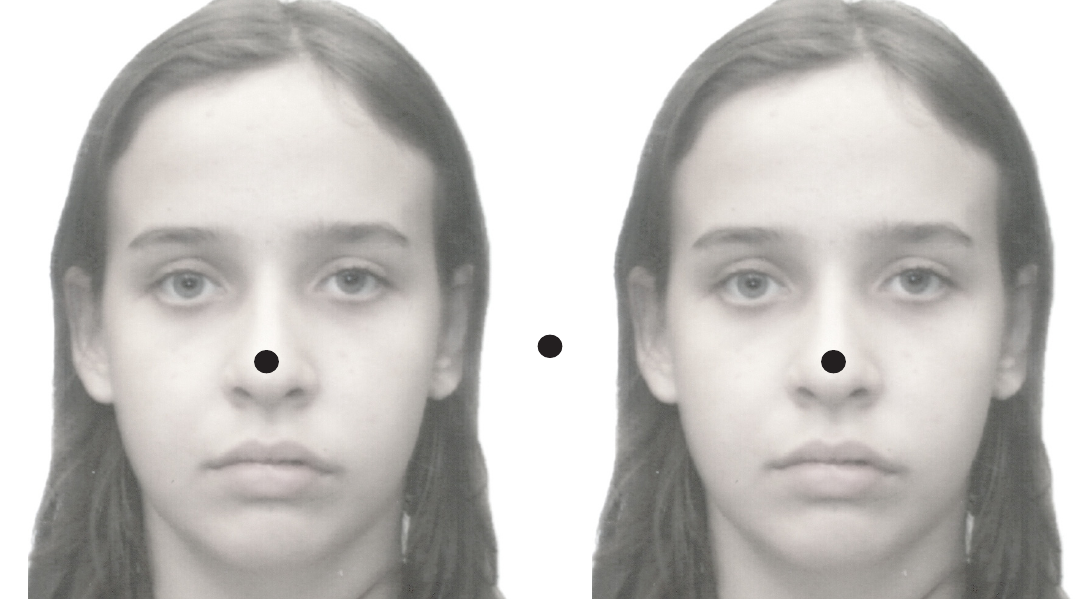
Figura 2. Faces-estímulo para observação do fenômeno de muitas-faces no lado contralateral ao ponto cego. O ponto de fixação é sempre o do centro. Por exemplo, com o olho direito fechado fixe o ponto central e mova o papel para frente ou para trás até o ponto preto da imagem à esquerda desaparecer. Mantenha esta distância e observe o fenômeno na face onde o ponto preto permanece, i.e., a face à direita.